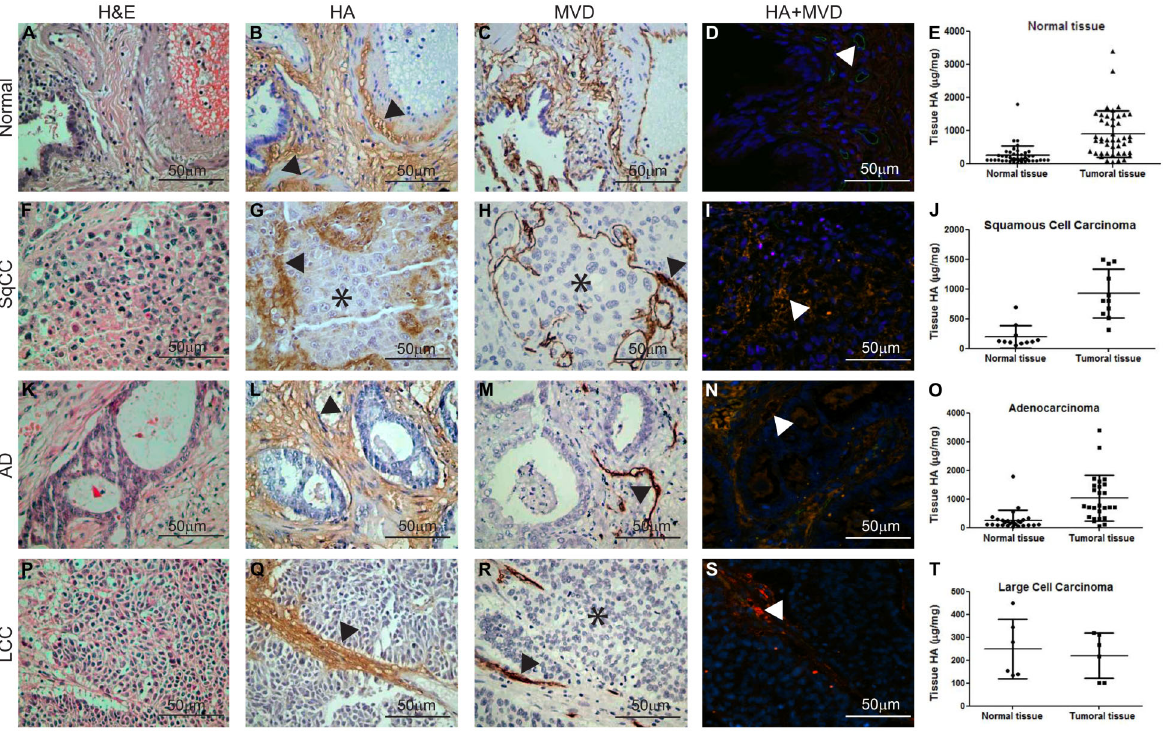
Figure 1. Strong hyaluronan (HA) signal at the epithelial cell-extracellular matrix interface ( B ) in normal lung ( A ), coincident with regular microvessels staining ( C ), absence of colocalization at confocal microscopy ( D ) and low signal when compared to tumoral tissue ( E ). High expression ( > 48%) of HA in squamous cell carcinoma (SqCC) ( F ) on cancer cells-stroma interface ( G ), coincident with high microvessel ( > 33%) staining foci ( H ), identical colocalization at confocal microscopy ( I ) and higher signal when compared to normal tissue ( J ). HA-negative in normal lung ( K ) and cells of adenocarcinoma (AD) ( L ); note the strong HA staining in tumor stroma ( L ), coincident with microvessels staining ( M ), foci of colocalization at confocal microscopy ( N ) and higher expression compared to normal tissue ( O ). Very poor signal in normal lung ( P ) and in large cell carcinoma (LCC) ( Q ); note strong HA foci staining ( Q ), coincident with focal microvessels density ( R ), focal colocalization at confocal microscopy ( S ) and low signal when compared to normal tissue ( T ). Arrowheads indicate stromal tissue; asterisks indicate carcinoma cells. H&E: hematoxylin and eosin; MVD: microvessel